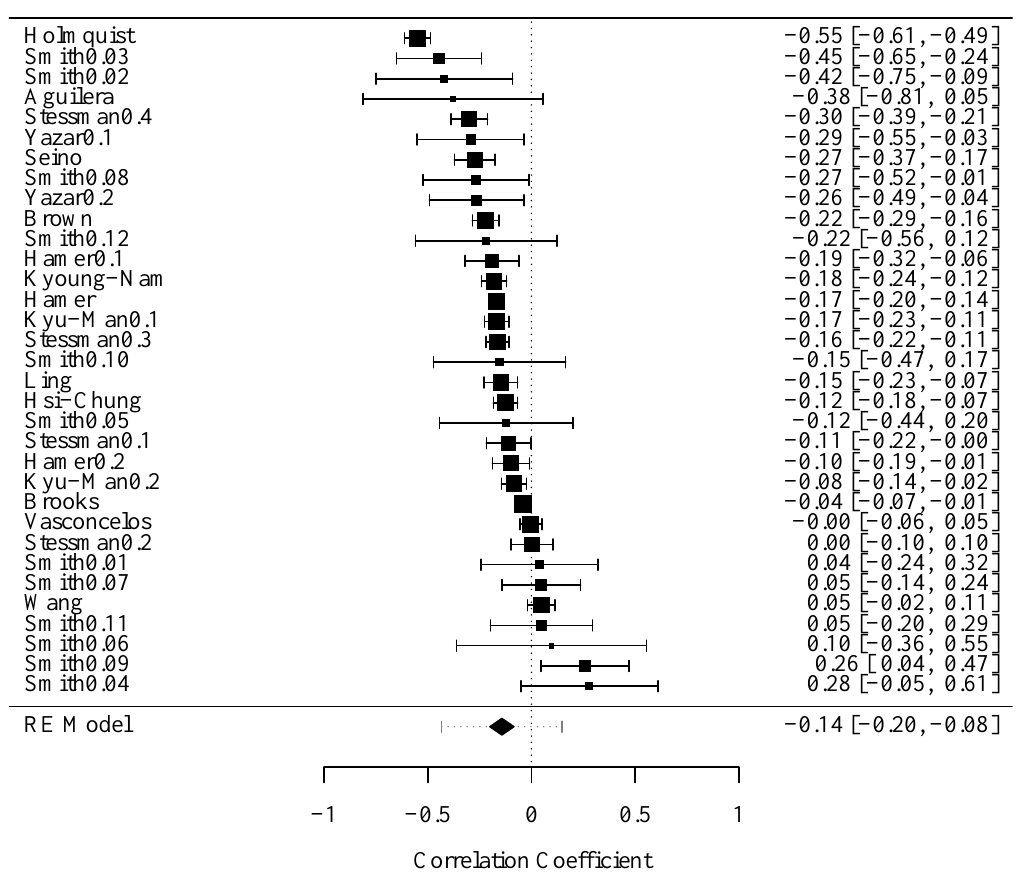
Figure 2. Forest plot of effect sizes (squares) with the overall result (diamond).